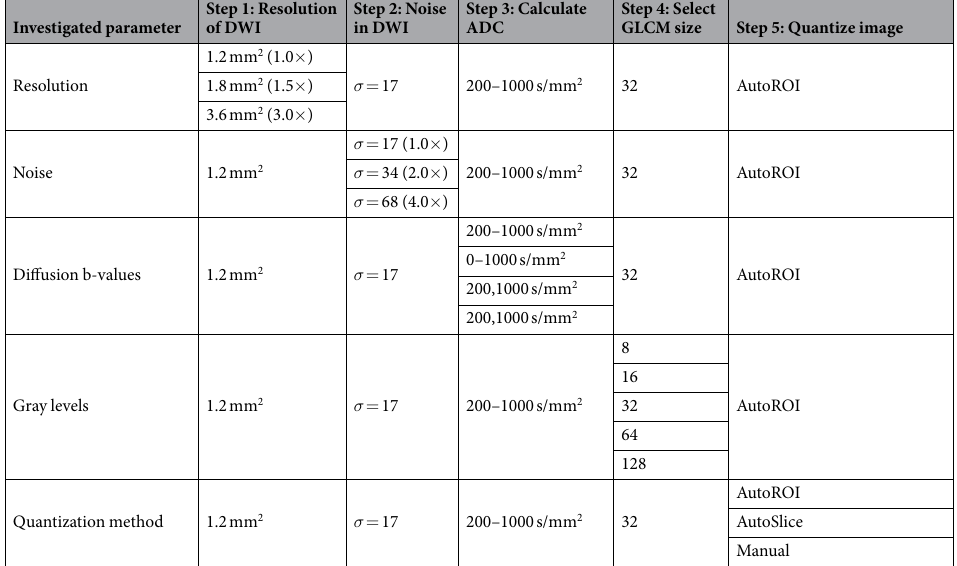
Table 4. The pre-processing work flow and settings for each investigated parameter for the glioma data. Each row represents the work flow of one investigated parameter. The prostate cancer data set used a similar work flow, where the native resolution was 1.625 mm 2 , the native noise standard deviation was σ = 2.5, and the ADC was calculated using 0, 800 s/mm 2